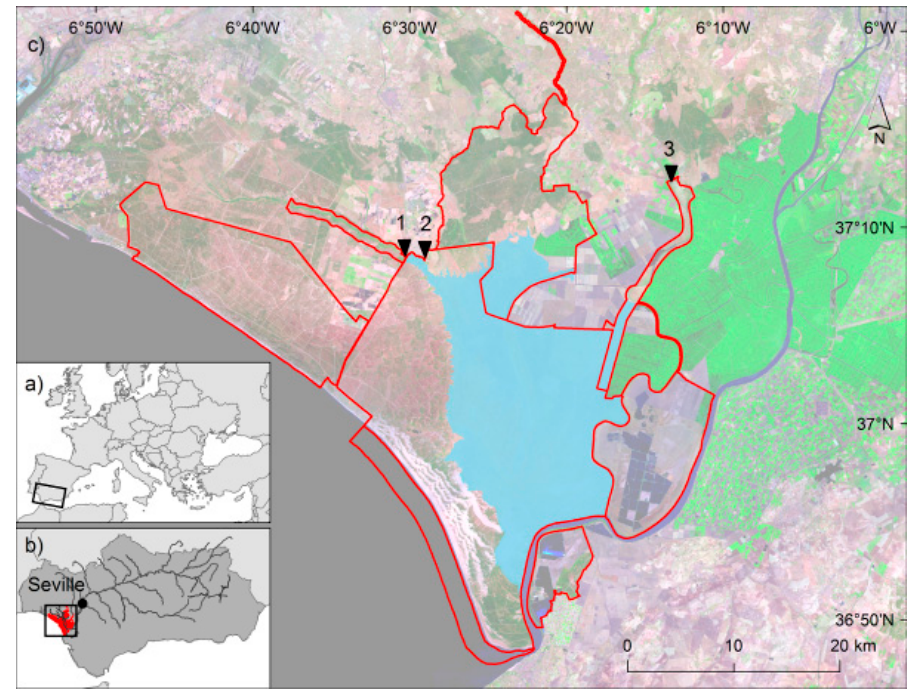
Figure 1. Location of ( a ) Andalusia in Europe and ( b ) Doñana in Andalusia at the mouth of the Guadalquivir River; ( c ) the area covered by Doñana natural marshes (solid blue) within the protected area of Doñana National and Natural parks (red line). Numbers indicate main tributary rivers and ravines (1. Arroyo de la Rocina ; 2. Arroyo del Partido ; 3. Encauzamiento del Río Guadiamar ). Background: False color composite of a 2007 Landsat TM image.